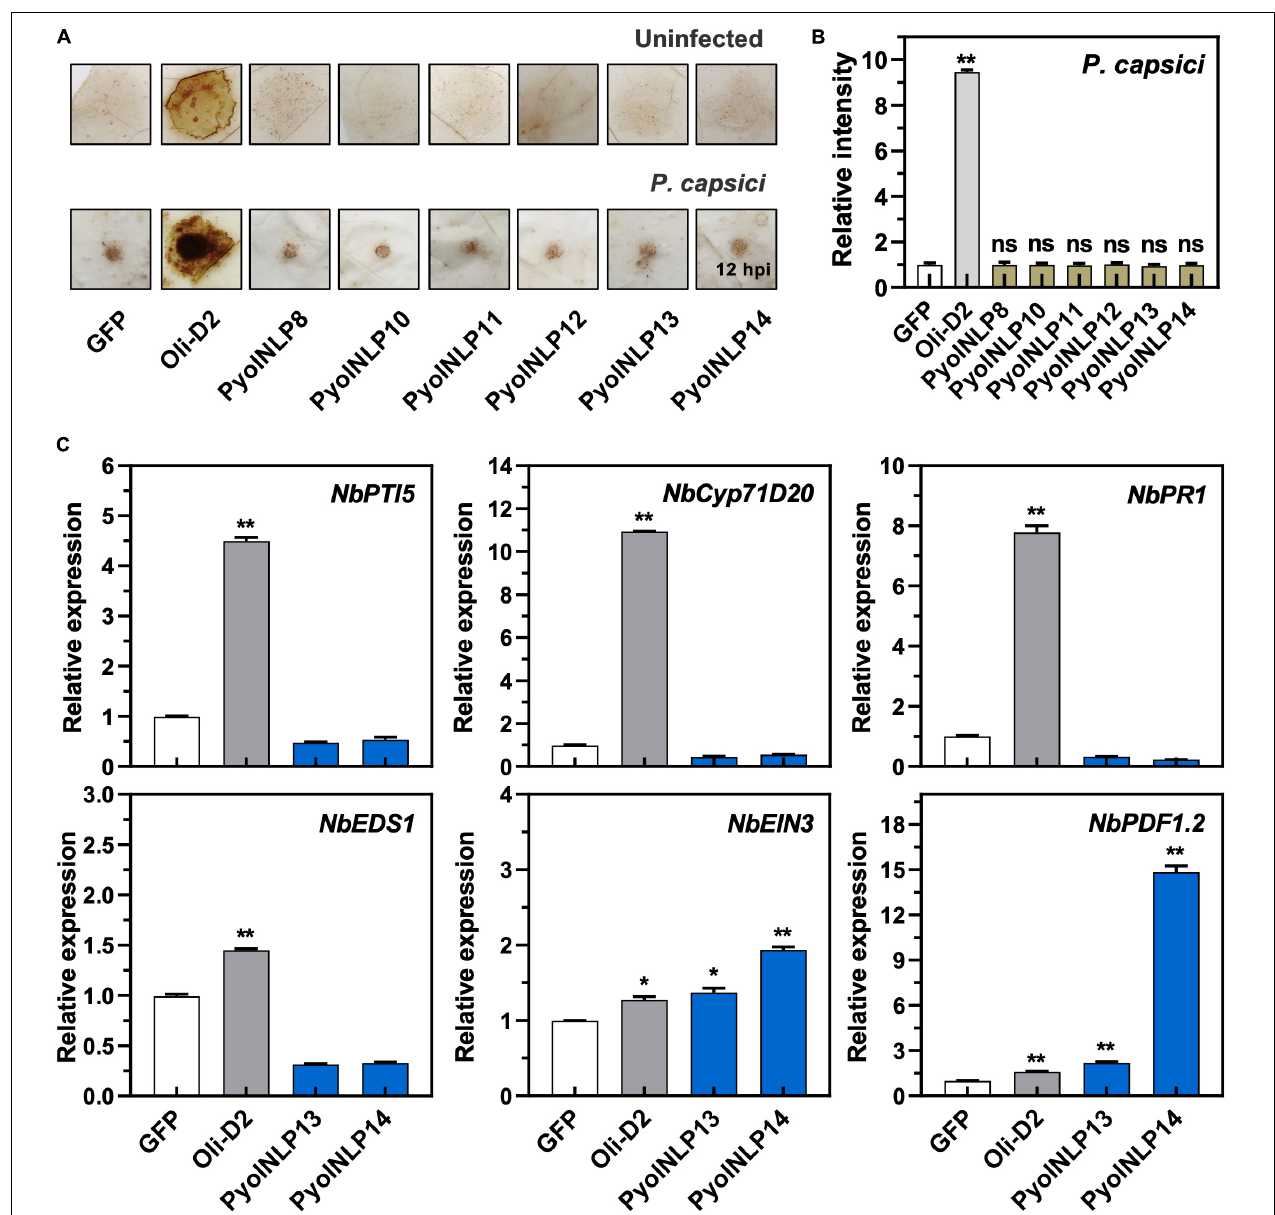
FIGURE 5 | Non-cytotoxic PyolNLPs cannot trigger ROS accumulation and instead induce PDF1.2 expression in N. benthamiana . (A) H 2 O 2 accumulation on infiltrated N. benthamiana leaves expressing GFP, Oli-D2, PyolNLP8, PyolNLP10, PyolNLP11, PyolNLP12, PyolNLP13 or PyolNLP14. was at 0 or 12 hpi. Oli-D2 acts as a positive control. DAB staining was performed at 12 hpi after P. capsici inoculation. (B) Relative ROS intensities in N. benthamiana leaves infiltrated with non-cytotoxic PyolNLPs were measured at 12 hpi using ImageJ. Error bar represents mean ± SD. ( n = 3). (C) Relative expression levels of PTI5 , Cyp71D20 , P R1 , EDS1 , EIN3 and PDF1.2 in agroinfiltrated N. benthamiana leaves expressing GFP , Oli-D2 , PyolNLP13 or PyolNLP14 . GFP and Oli-D2 were used as negative and positive controls, respectively. Error bar represents mean ± SD ( n = 3). Data were analyzed by Median-edition Levene’s test to determine the homogeneity of variance across groups, and then analyzed by one-way ANOVA with post-hoc Tukey’s range test for groups with equal variance (* P < 0.05;** P < 0.01). All experiments were repeated at least three